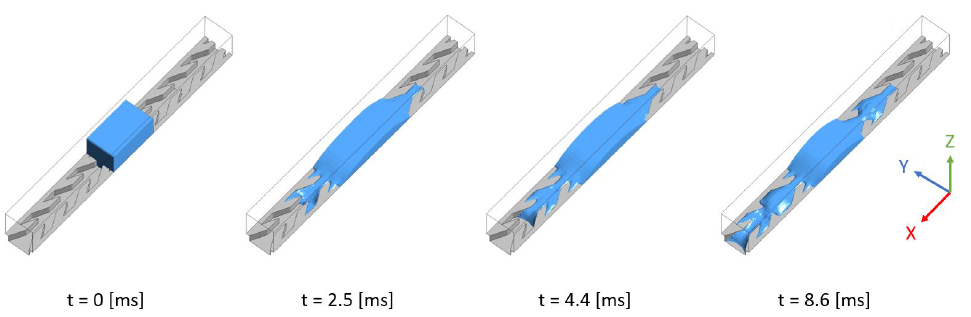
Figure 11. 3D simulation of liquid wicking driven by capillary forces on channel A. Blue color represents liquid volume. Contact angle is 50°. The simulation domain is eight elementary cells long. The parallelepiped size is (cid:96) x = 0.7 mm, (cid:96) y = 0.38 mm, and (cid:96) z = 0.4